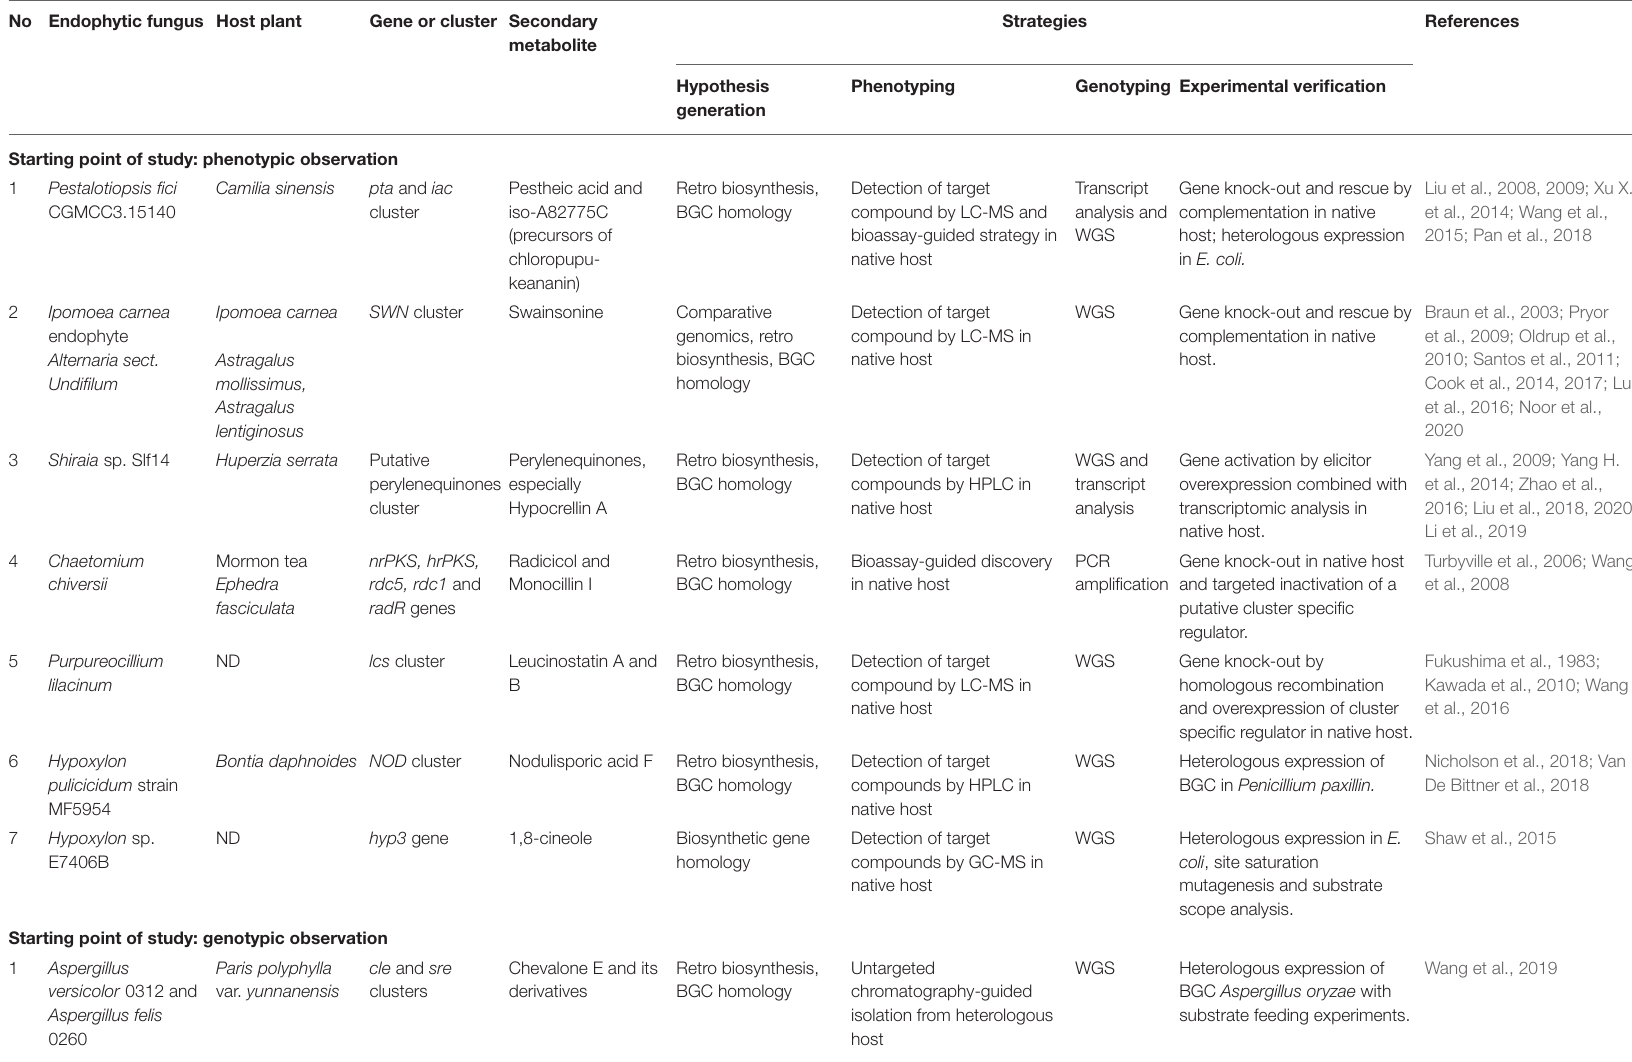
TABLE 2 | Successful studies in linking phenotype and genotype of the related bioactive secondary metabolites from plant endophytic fungi supported by experimental verifications. No Endophytic fungus Host